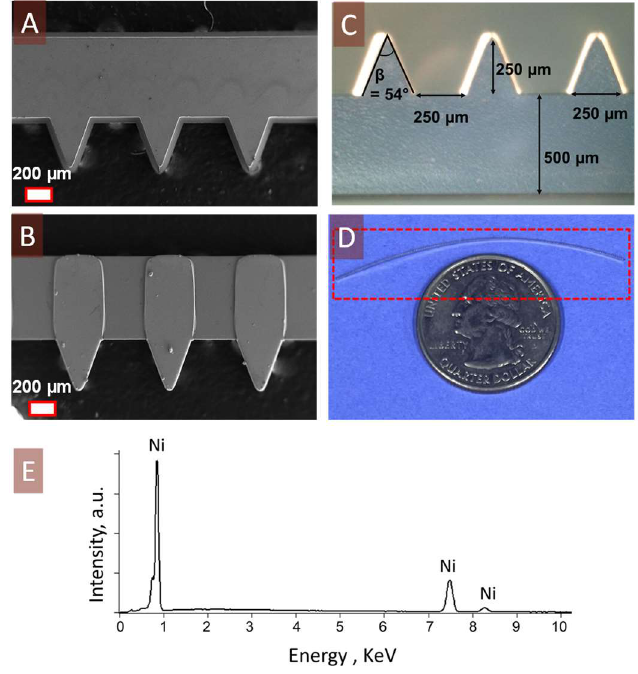
Figure 4. ( A , B ) SEM images of the fabricated micro saw bottom, and top view, ( C ) 3D optical microscope image showing micro saw tooth anatomy, β = wedge angle, ( D ) photograph of the fabricated micro saw size comparison with the US quarter coin, and ( E ) EDX analysis of the device.